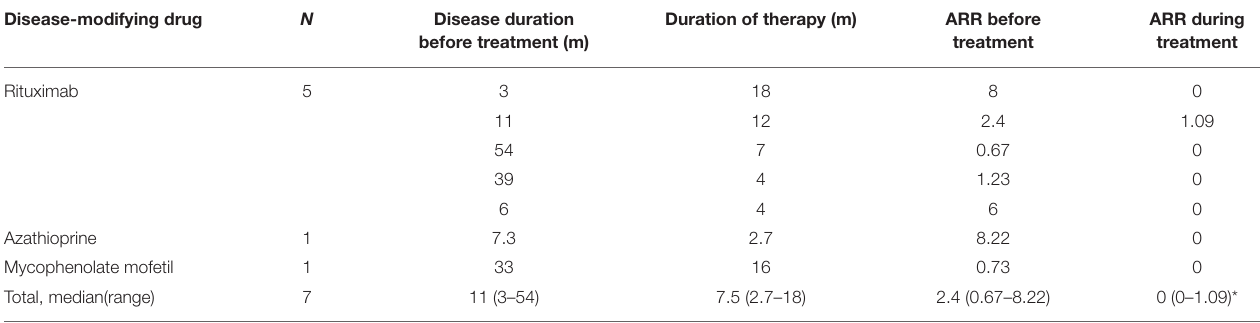
Duration of therapy (m) ARR before ARR during before treatment (m) treatment treatment